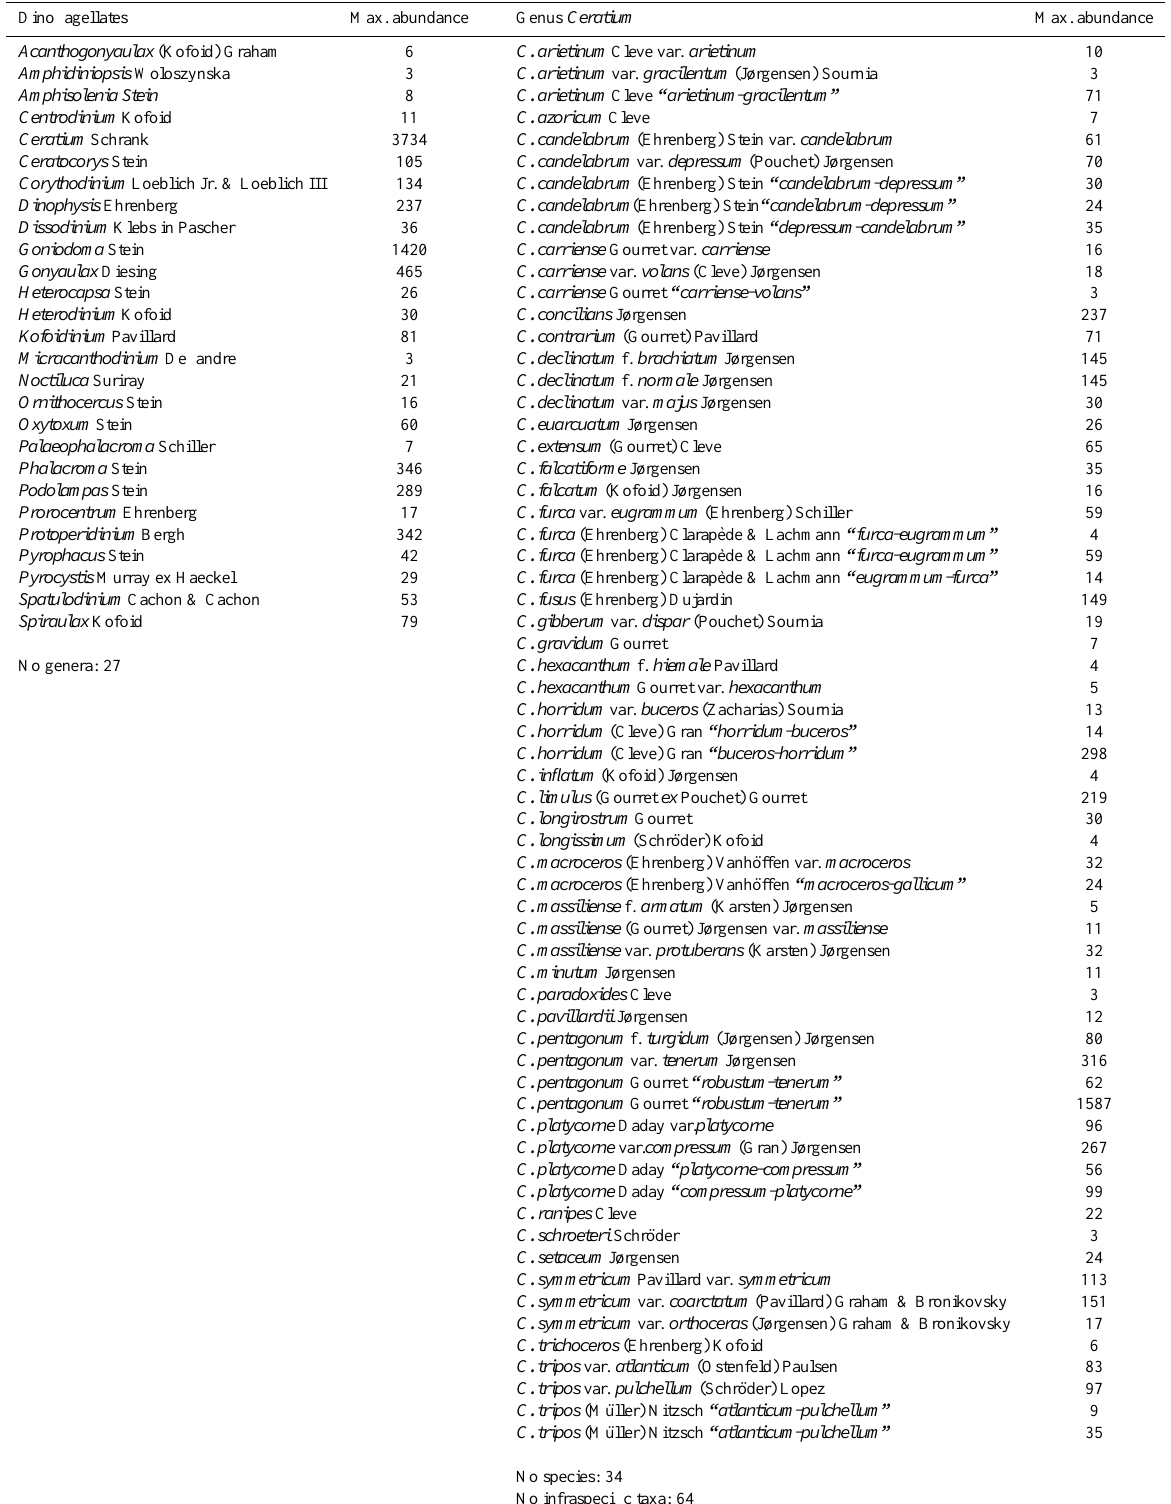
Table 2. List of dinoflagellates genera and Ceratium taxa encountered in net samples during DYNAPROC 2 cruise, with maximal abundance recorded in samples in cells per